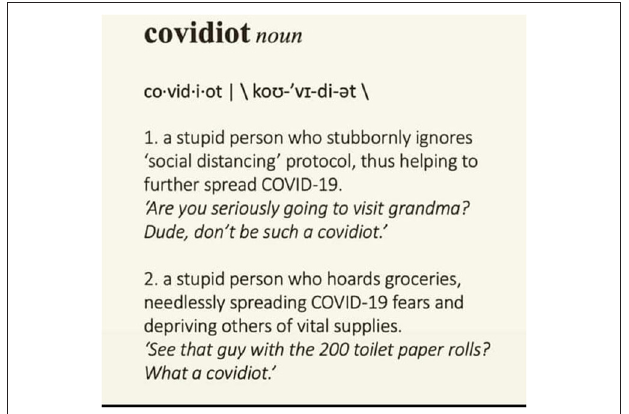
FIGURE 1 | English definition of covidiot shared on Twitter (https://pbs.twimg. com/media/ETqO70GWsAEEX9A?format=jpg&name=medium).